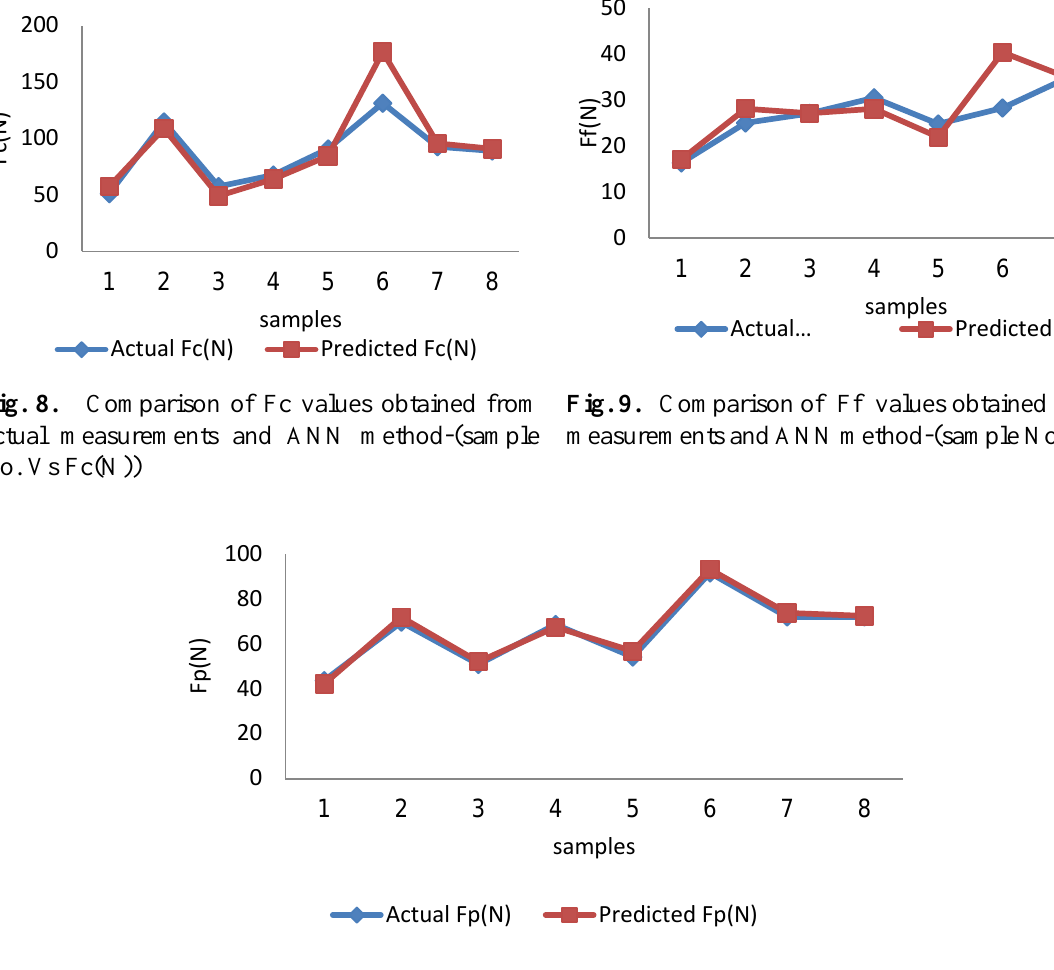
Fig. 10 Comparison of Fp values obtained from actual measurements and ANN method-(sample No. Vs